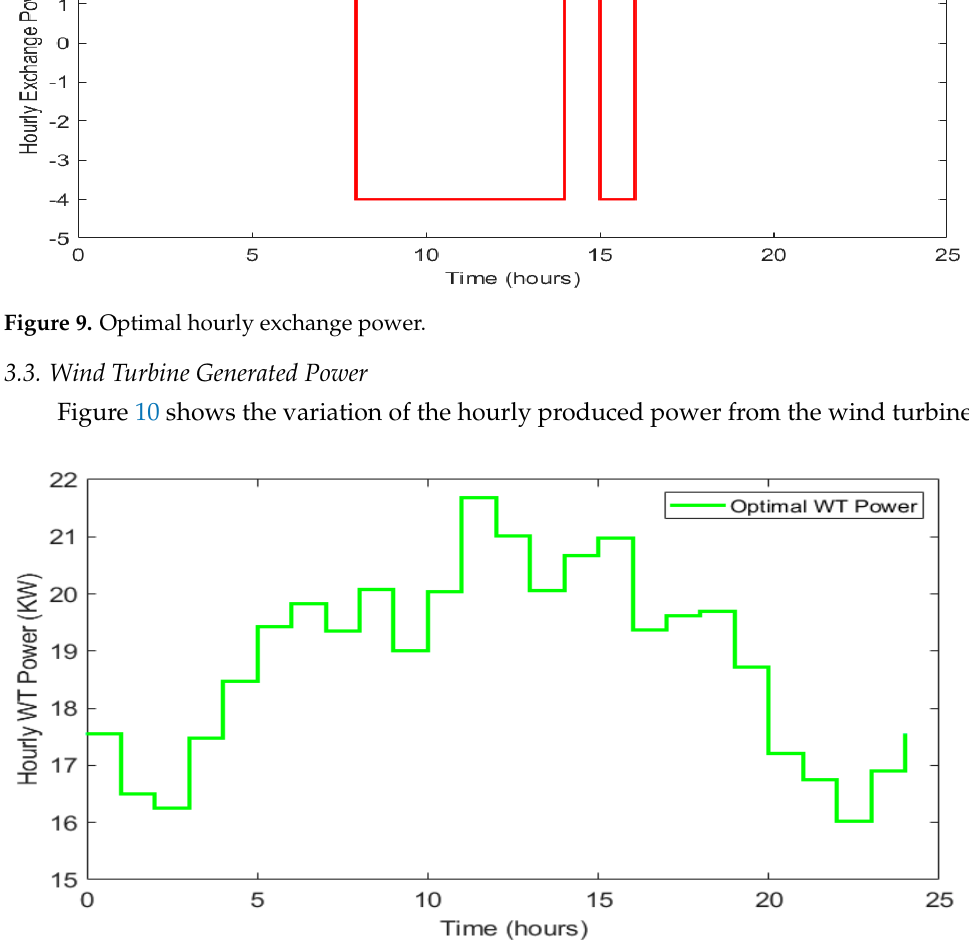
Figure 10. Optimal hourly WG power.